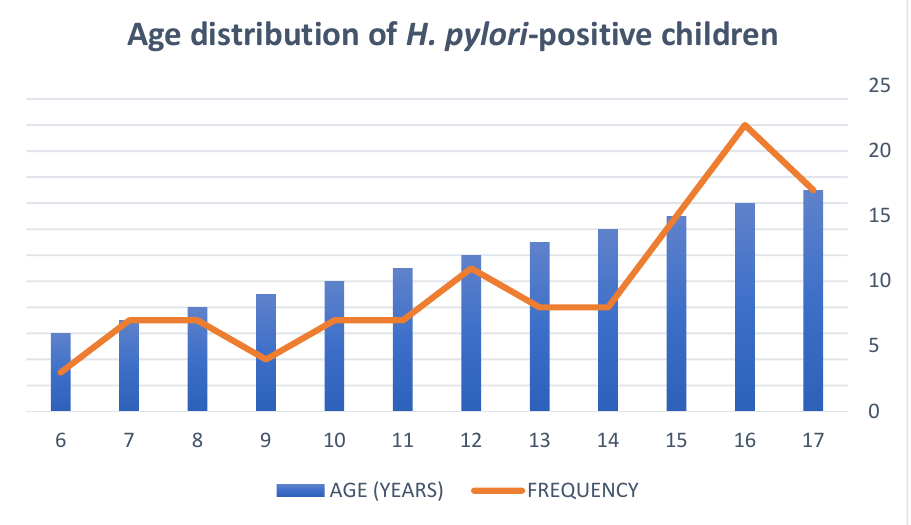
Figure 1. Age distribution of H. pylori -positive children.